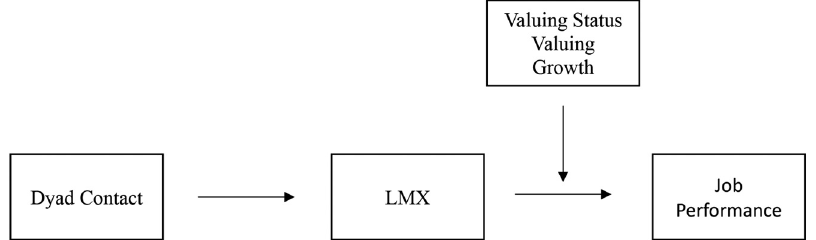
Figure 1. Proposed model of LMX – performance relationships using follower only subsample ( H2 ,